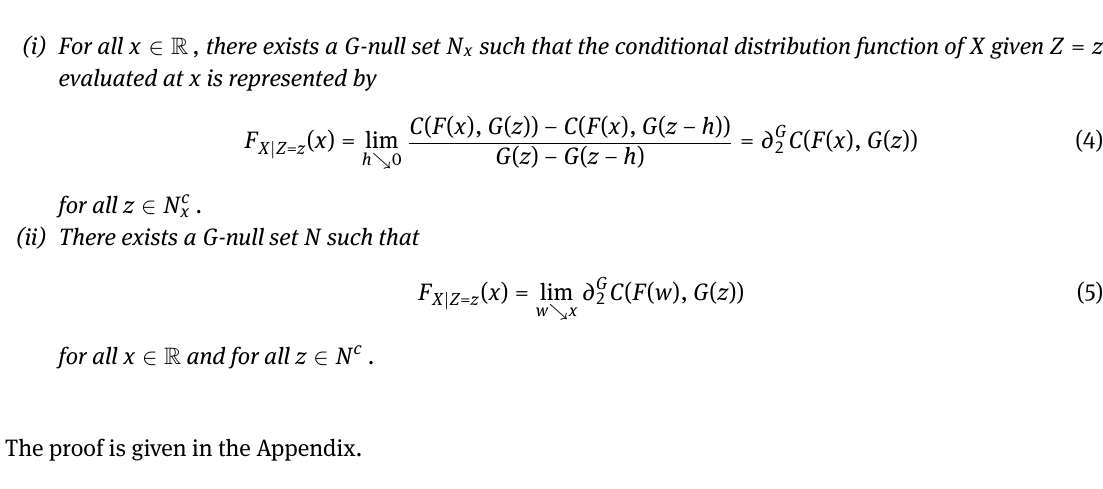
Figure 2 On the left: a distribution function G ; on the right: its corresponding transformations ι G (dashed and solid line) and (dotted and solid line) which both coincide with the identity function on the interior of the range of G . Note that ι − ι − G continuous, and ι is neither left- nor right-continuous, see Lemma G